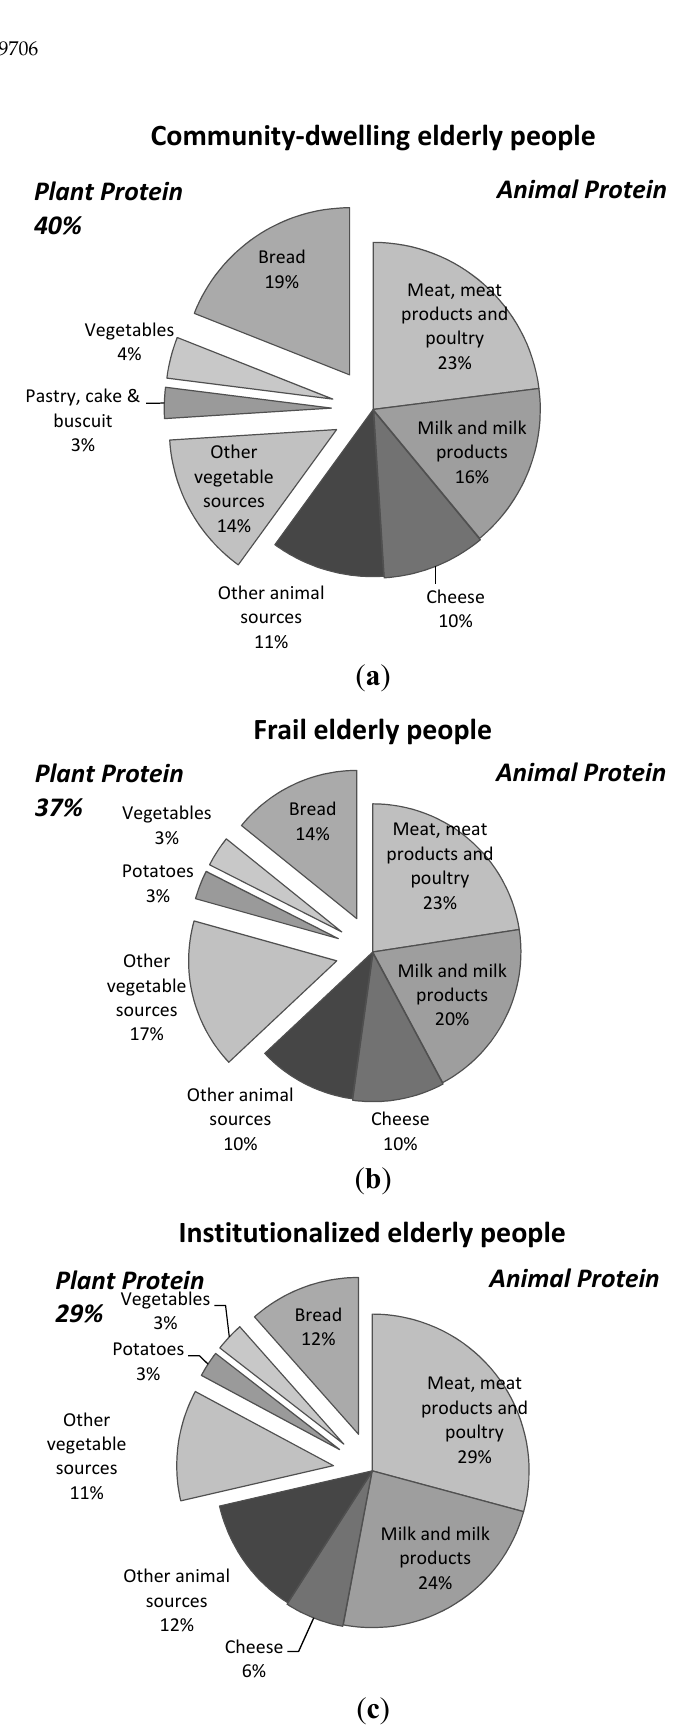
Figure 2. Contribution of plant and animal protein sources to total daily protein intake in community ‐ dwelling ( a ); frail ( b ) and institutionalized elderly people ( c ).